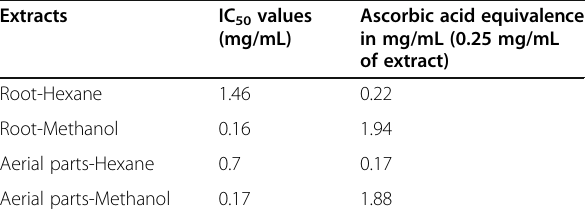
Table 4 IC 50 and ascorbic acid equivalence of the extracts of V . coriaceum in ABTS scavenging